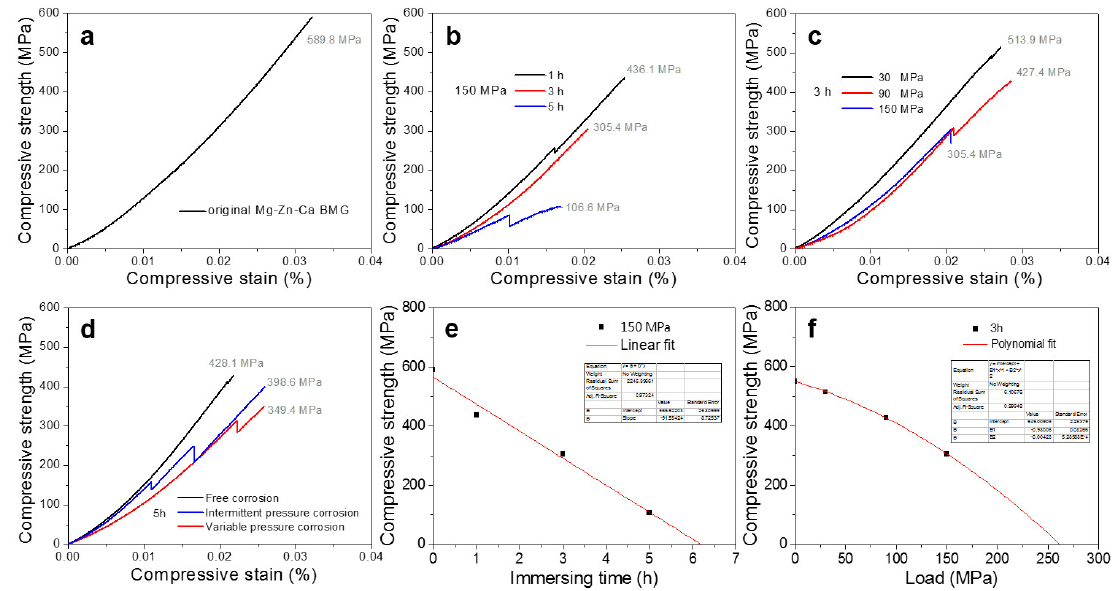
Figure 6. Compressive curves of original Mg-Zn-Ca amorphous alloys ( a ), Sample 1–3 ( b ), Sample 2, 4 and 5 ( c ); ( d ) Sample 6–8; ( e ) linear fitting of ( b ); ( f ) polynomial fitting of ( c ).